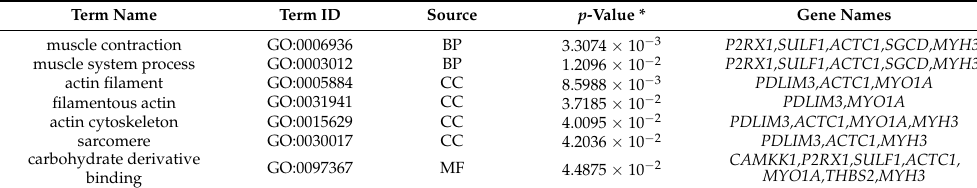
Table 4. The results of Gene Ontology analysis for differentially expressed genes detected in ff-FGR samples.